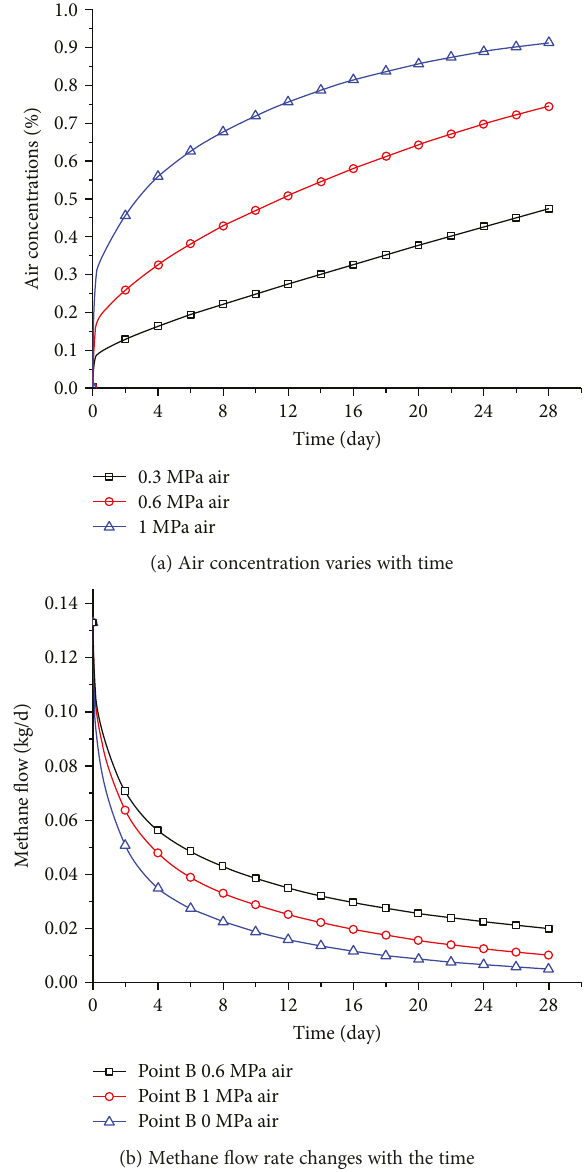
Figure 13: Methane fl ow rate changes with time.